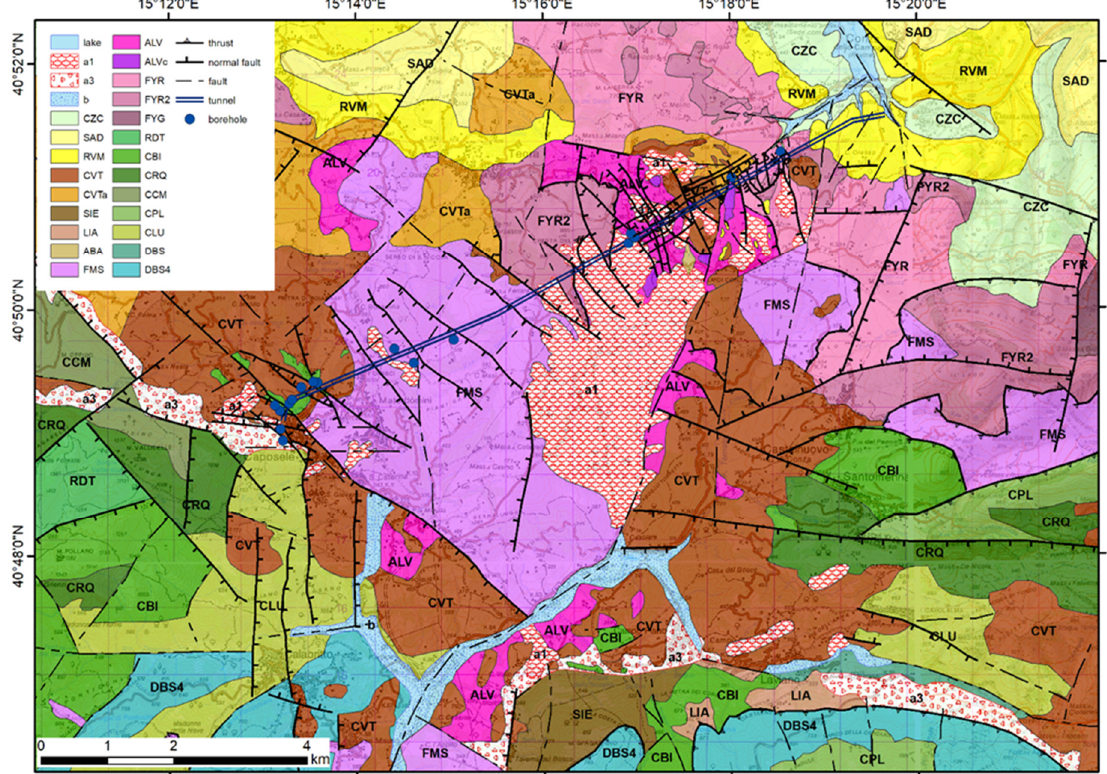
Figure 4. Geological map of the study area, indicating the Pavoncelli-bis tunnel track and the location of the boreholes performed in the different survey campaigns. Legend: a ) Sicilide unit — Monte S. Arcangelo Fm. (FMS), Argille Varicolori Superiori Fm. (ALV) and calcareous lithofacies (ALVc), Albanella/Corleto unit (ABA); b ) Mt. Picentini unit—Dolomia Superiore fm. (DBS) and Megalodon limestones and dolostones member (DBS4), Cladocoropsis and Clypeina limestone fm. (CCM), limestone and dolomitic limestone fm. (CLU), requienia and gasteropods limestone fm. (CRQ), Radiolitidae Limestone fm. (RDT), bio-litoclastic rudist limestone fm. (CBI); c ) Mt. Marzano unit— DBS, CLU, CRQ, Palaeodasycladus limestone fm. (CPL), “Pseudosaccharoidal” limestones lithofacies (CBIa), Laviano calcarenites fm. (LIA); d ) Frigento unit—Flysch Galestrino Fm. (FYG), Flysch Rosso Fm. (FYR) and limestone member (FYR2), pre-numidian sequence (FYN); synorogenic units—Monte Sierio Fm. (SIE), Castelvetere Formation (CVT) with silty-clayey-marly lithofacies (CVTa), Andretta Synthem (SAD), Ruvo del Monte Synthem (RVM); Quaternary units—Conza della Campania synthem (CZC), debris slope talus (a3), terraced and actual alluvial deposits and alluvial fan ( b ),